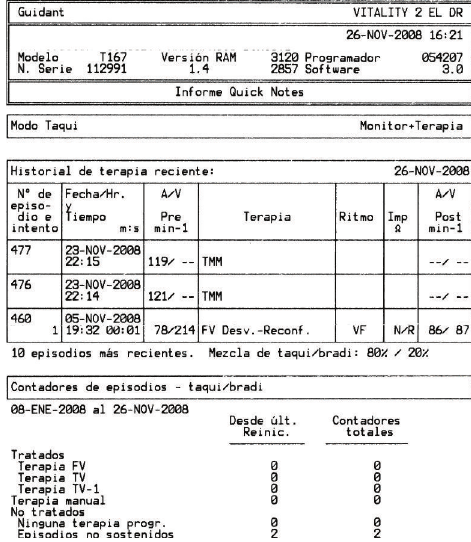
Figure 2: Therapy history: episode 460. Detection of ventricular fibrillation on November 5, 2008 at 19 : 32, coincident with the CT scan exam. Diverted therapy due to reconfirmation